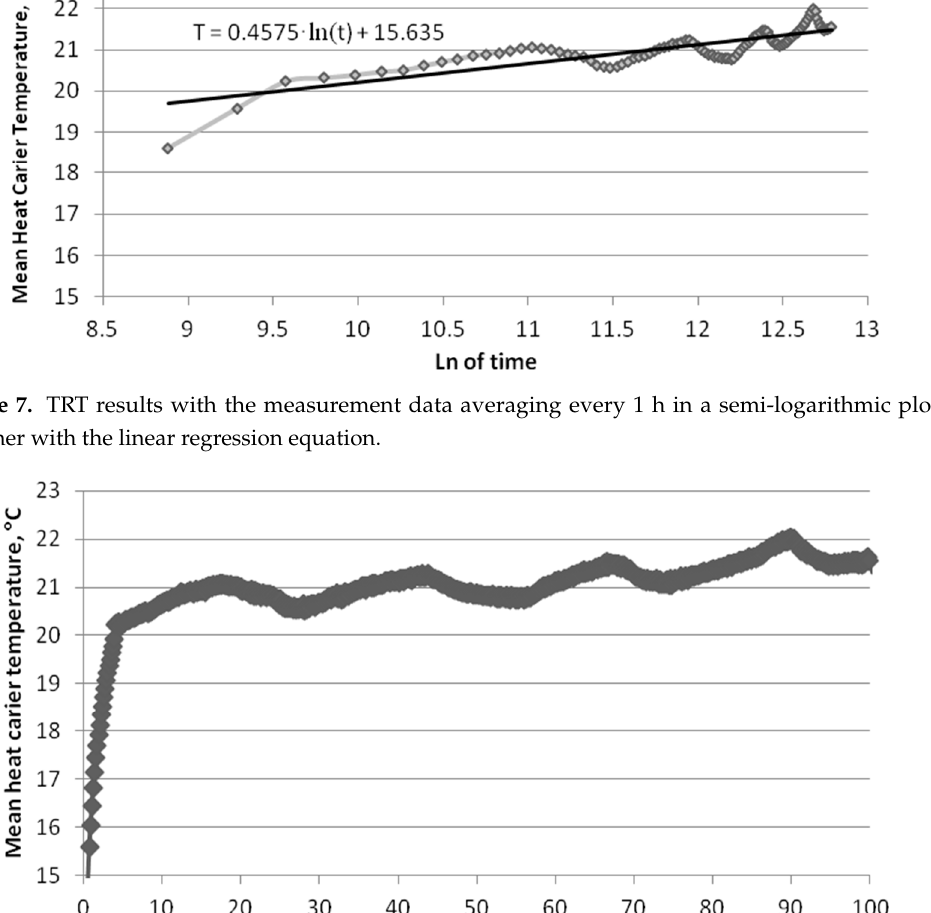
Figure 8. TRT results with the measurement data averaging every 10 min.